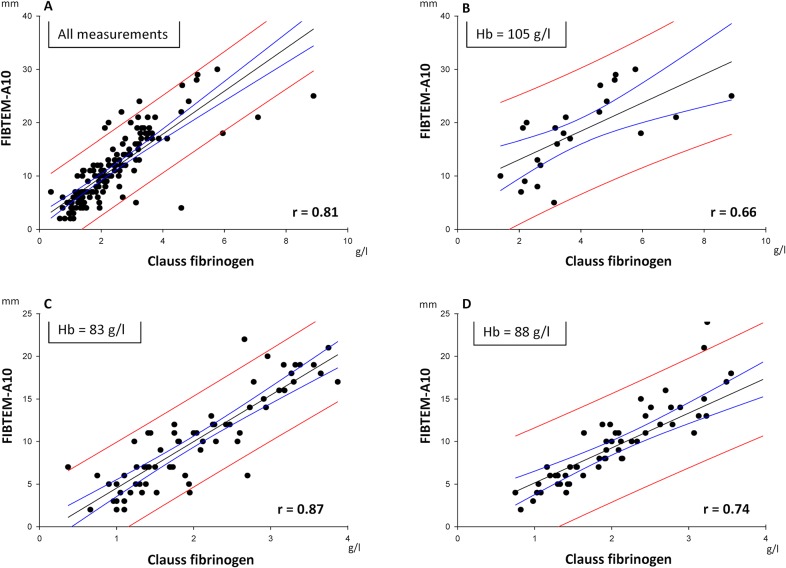
Relationship between Clauss fibrinogen and A10 according to operative period and mean hemoglobin.Regression analysis. Equation: Polynomial, linear. Blue lines = 95% Confidence Band; Red lines = 95% Prediction Band. A10, A10.